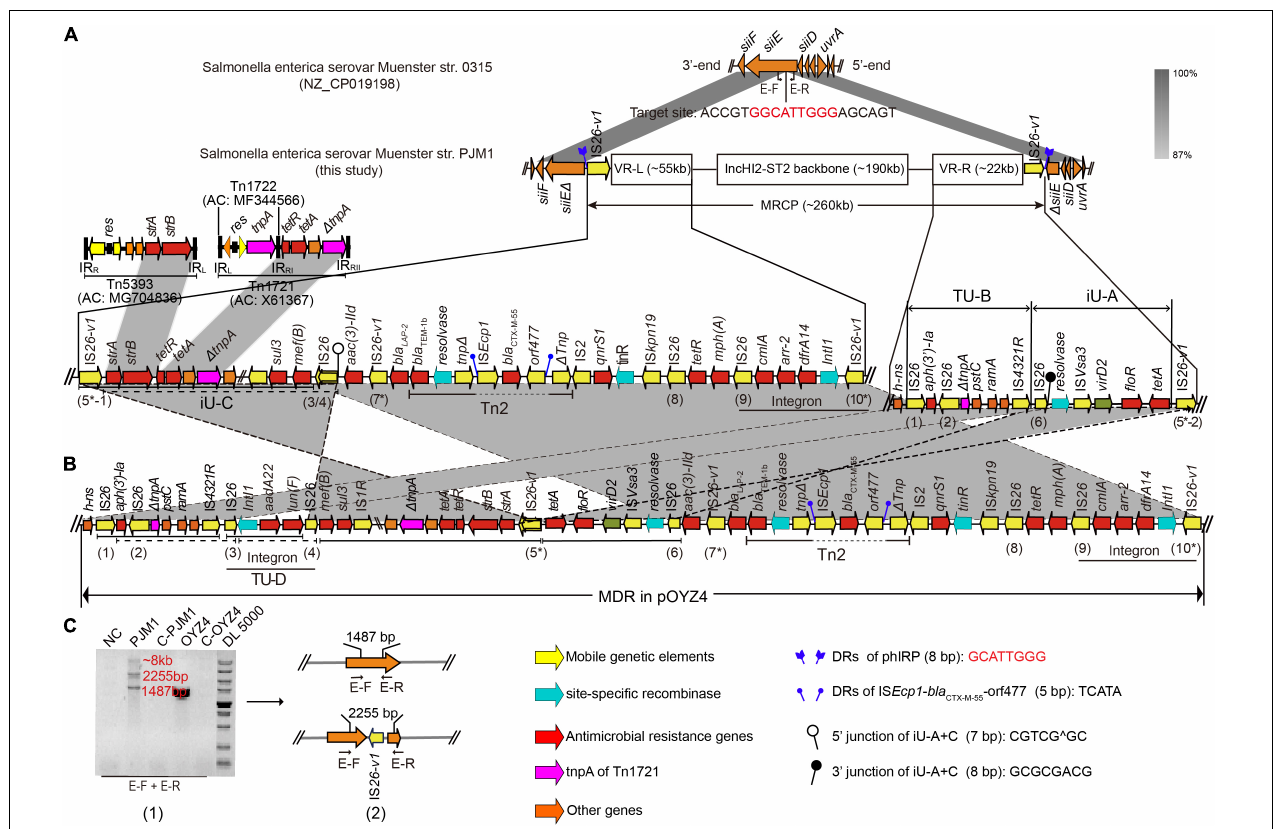
FIGURE 2 | The structure and location of MRCP in PJM1 chromosome. (A) Comparison between the genetic structure of PJM1 chromosome and S . Muenster str. 0315. (B) The left and right variable regions (VR-L and VR-R) of MRCP and the corresponding MDR regions in pOYZ4. The IS 26 elements (IS 26 and IS 26- v1) in pOYZ4 and MRCP are marked with numbers. (C) Gel electrophoretic diagram (1) of PCR amplicons of primer pairs E-F and E-R and the corresponding structure (2) detected. All amplicons were confirmed by sequencing. Primers are listed in Supplementary Table 1